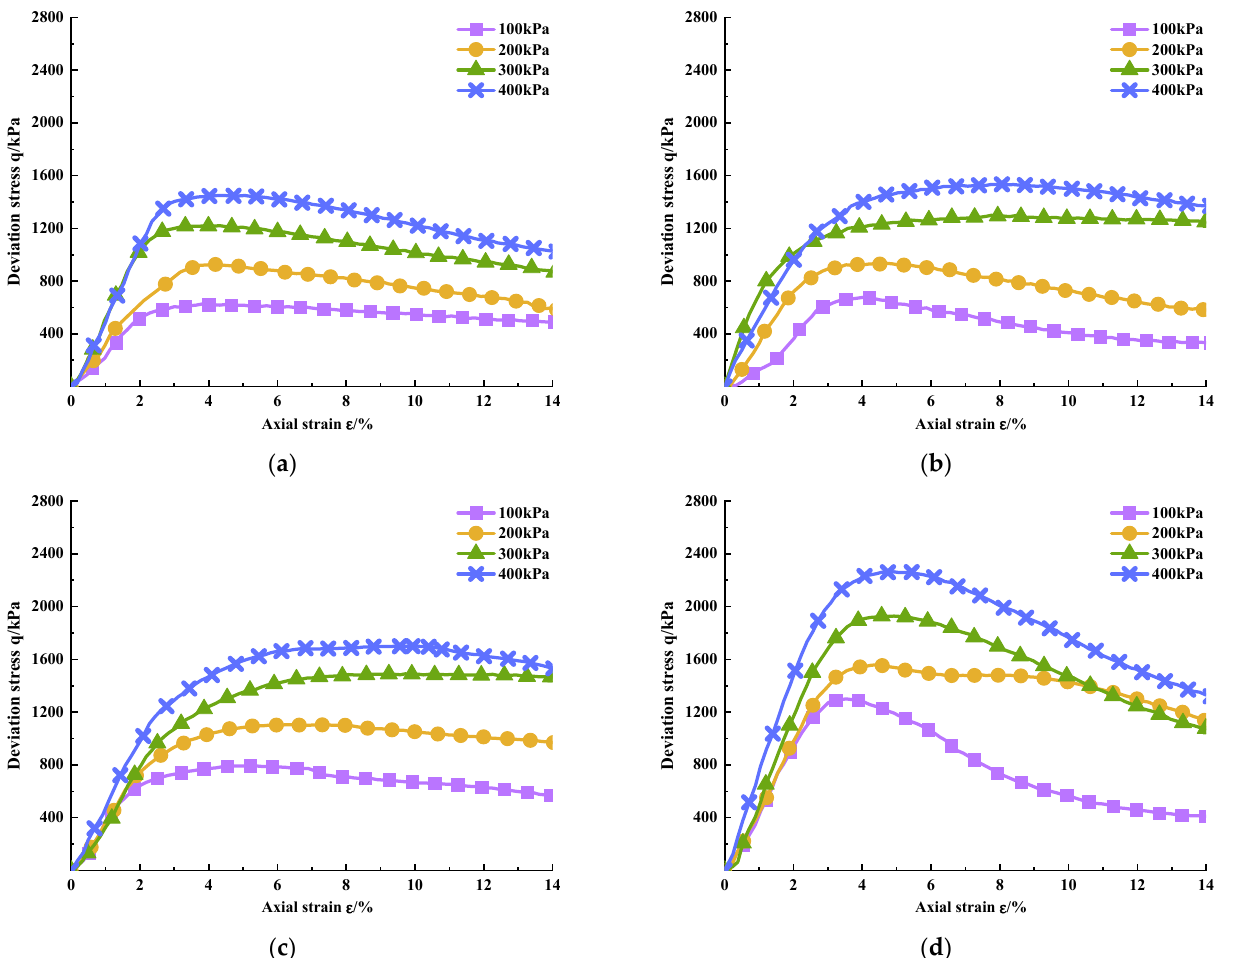
Figure 4. Deviatoric stress–strain curves of PURD at 7 days of curing time. ( a ) PURD-3; ( b ) PURD-4; ( c ) PURD-5; ( d ) PURD-6.